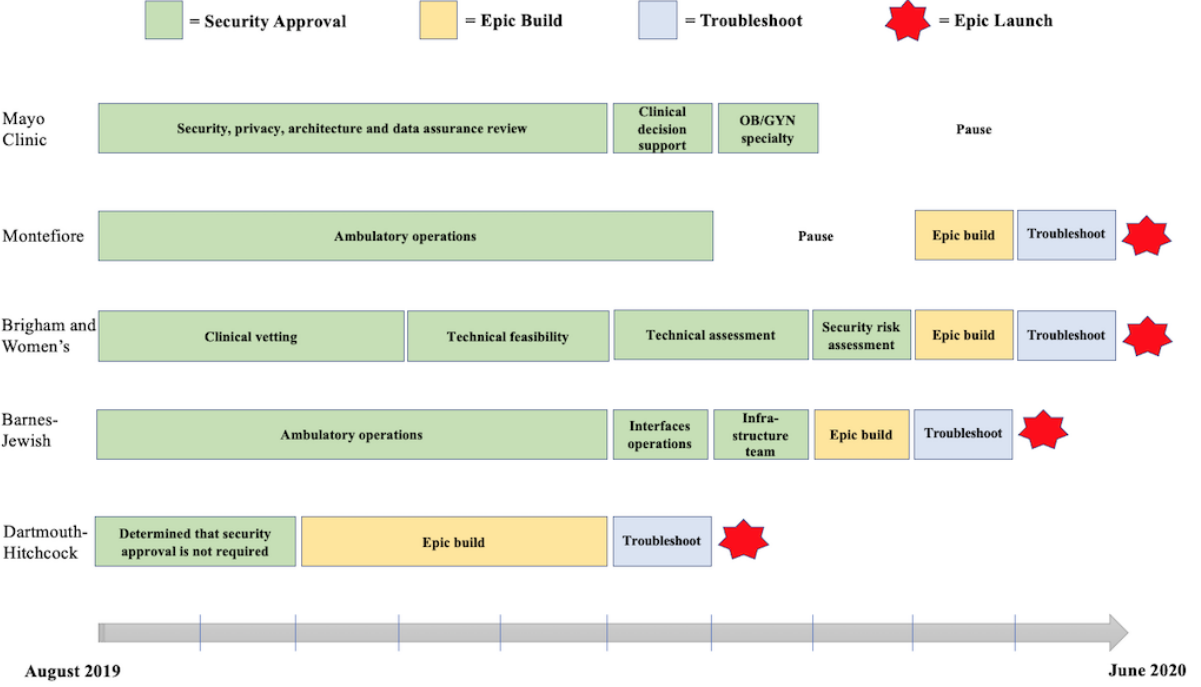
Figure 2. Timeline of the electronic health record integration of the Option Grid patient decision aid. OB/GYN: obstetrics and gynecology.